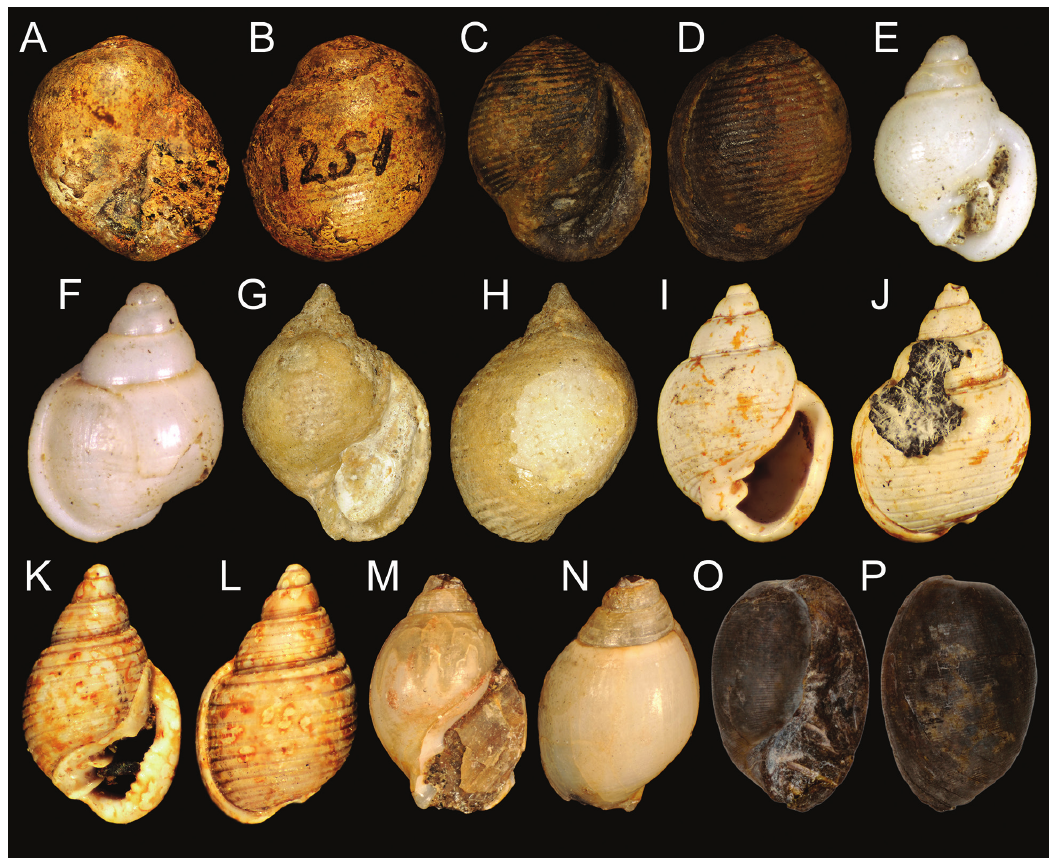
Figure 4. Types. A–B. Syntype of Cinulia naticoides , H 9.0 mm, ANSP IP18784. C–D. Syntype(?) of Cinulia rectilabrum , H 9.9 mm, ANSP IP4753. E–F. Holotype of Ringicula hypograpta , H 2.0 mm, ANSP IP3841. G–H. Syntype of Ringicula lata , H 15.4 mm, ANSP IP30695. I–J. Lectotype of Ringicula mississippiensis , H 3.7 mm, ANSP IP13414. K–L. Syntype of Ringicula trapaquara , H 2.3 mm, ANSP IP6468. M–N . Lectotype of “Ringicula” varia , H 7.1 mm, ANSP IP4264. O–P. Holotype of Roxania hornii new comb., H 20.1 mm, ANSP